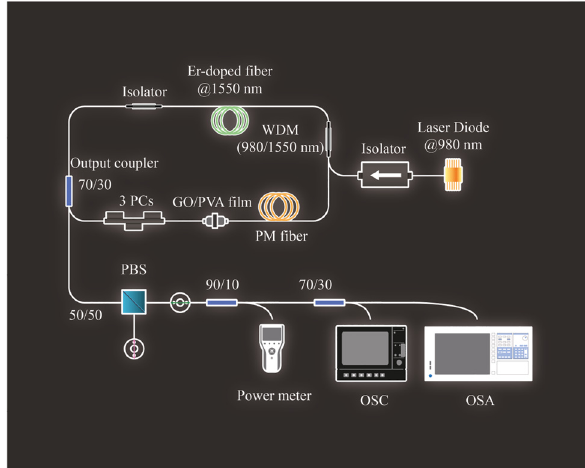
Figure 2: Experimental setup of ring configuration EDFL. (EDF: erbium doped fiber, WDM: wavelength-division multiplexing, ISO: isolator, PC: polarization controller, SA: saturable absorber (GO/PVA film), PMF: polarization maintaining fiber, PBS: polarization beam